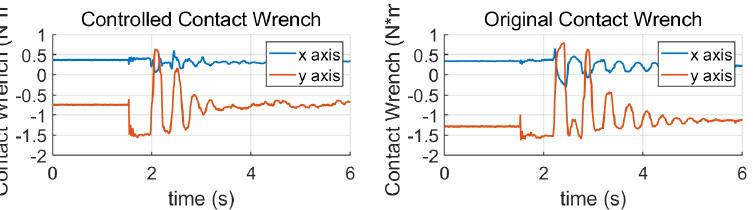
Figure 10. Changes of the contact wrench in standing balancing. The torque changes greatly in the Y direction of the sole.